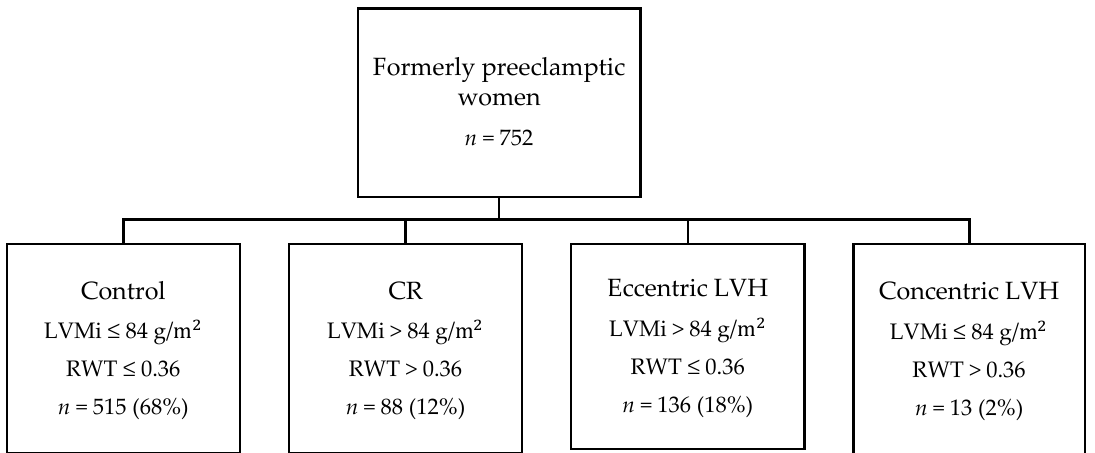
Figure 1. Flowchart of the study population. CR = concentric remodelling; LVH, left ventricular hypertrophy; LVMi, left ventricular mass index; RWT, relative wall thickness. Table 1. Data are given as mean values (±SD) or n / N (%) of 752 formerly preeclamptic women with normal geometry (control), CR, eccentric LVH, and concentric LVH varying 6 months to 5 years postpartum. Original data file was used, and groups were compared to control group with the ANOVA test. Binary variables were tested with the X 2 and Fisher’s exact test.